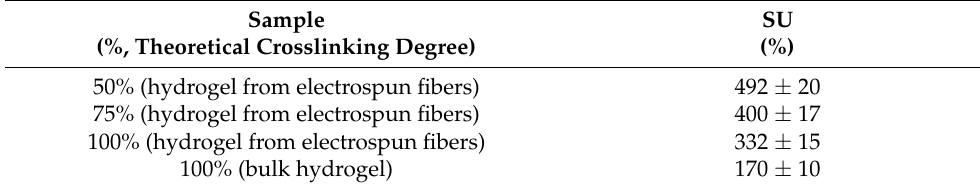
The averaged values over three independent measurements are given in Table 2. Table 2. Averaged solvent uptake percentage (SU) determined for the different hydrogels.